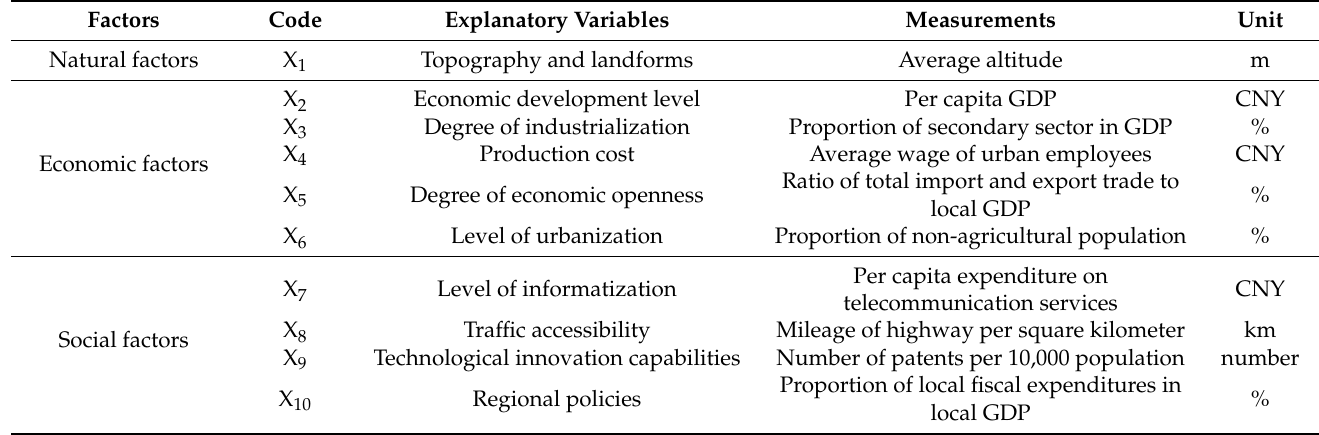
Table 1. Selection and interpretation of explanatory variables.